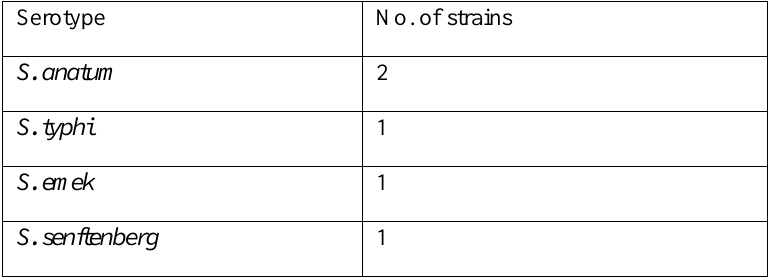
Table (5) serotypes isolated of Salmonella from Hospital person Serotype